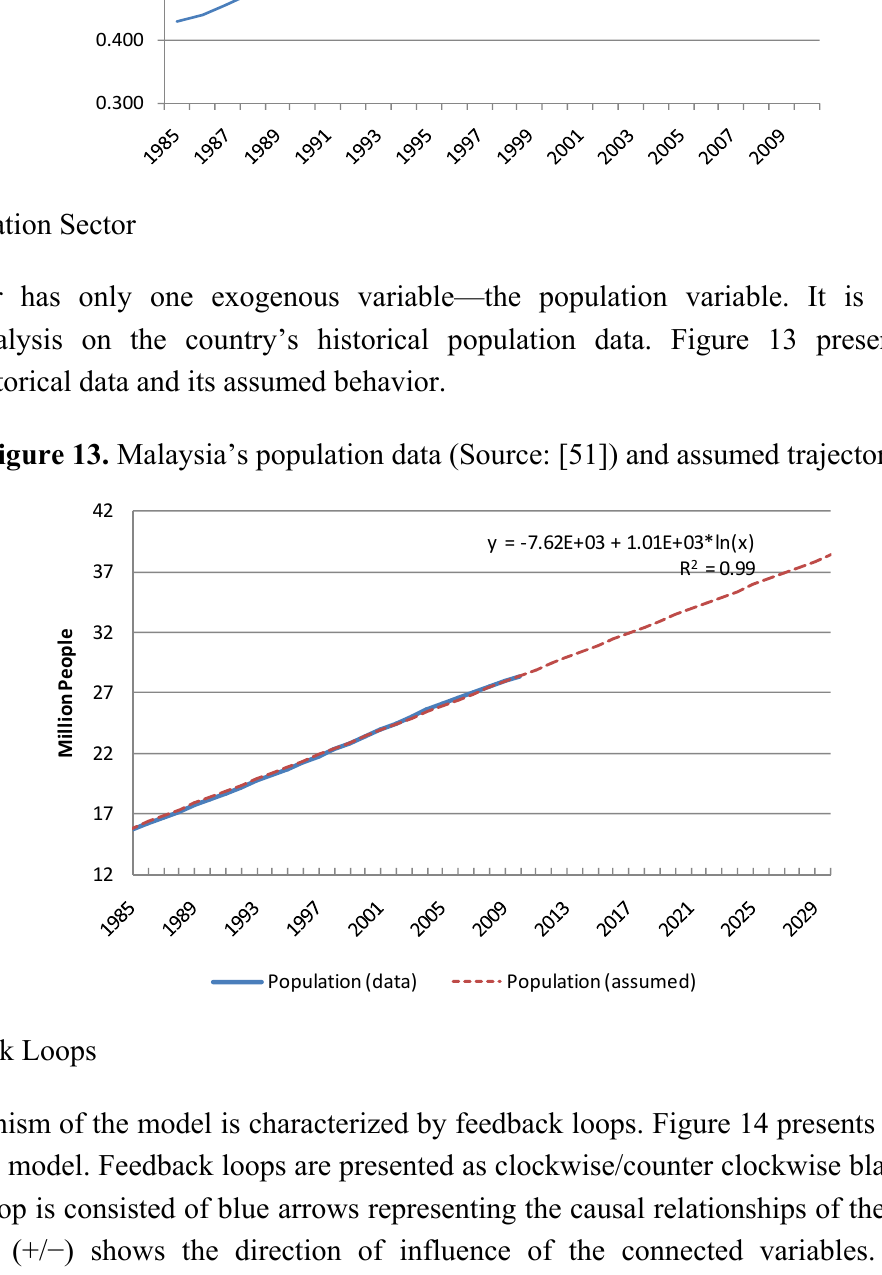
Figure 12. Malaysia’s ITA